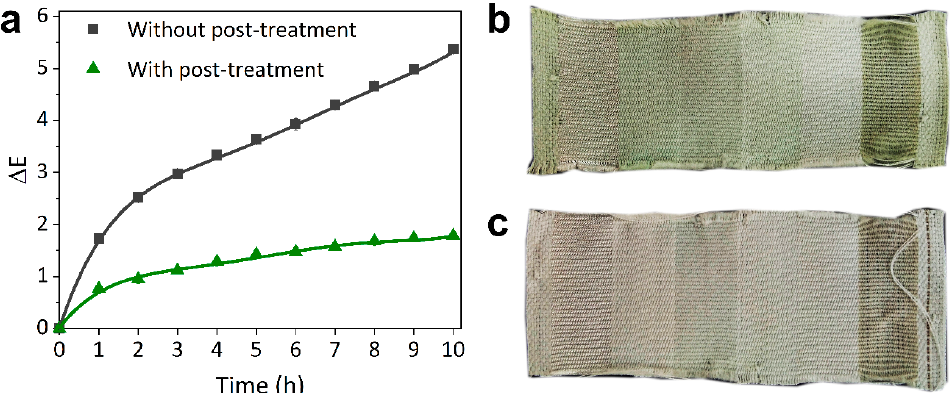
Figure 5. ( a ) ∆ E of the SCC-dyed fabric with and without post-treatment caused by exposure to simulated sunlight radiation (with a wavelength range from 350 to 780 nm), and the multi-fiber reference fabric of the SCC-dyed fabric ( c ) with and ( b ) without post-treatment after the wash fastness test (ISO 105 C-06).